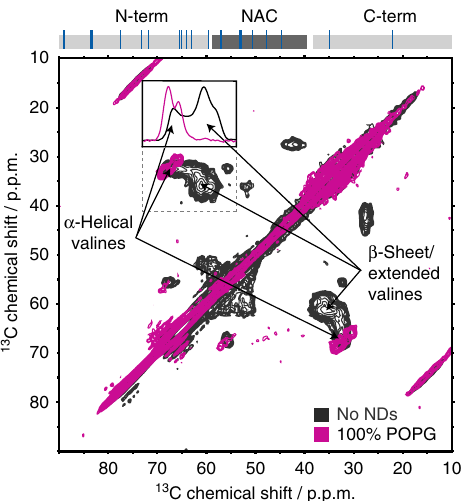
Fig. 2 Nanodiscs binding induces α -helical structure in α S. [ 13 C- 13 C]-Proton driven spin diffusion magic angle spinning-DNP spectra of free non- acetylated α S in frozen solution (black) and when bound to NDs with 100% POPG lipids (purple). Selective isotope labeling was used to speci fi cally monitor valine C α -C β chemical shift distributions. Peak positions indicative of β -sheet and α -helical secondary structure are labelled. The insert shows normalized 1D projections of the highlighted region (dashed square) in the absence (black) and presence of 100% POPG NDs. Signal deconvolution of these spectra reveals that about 92% of the valines are in an α -helical con fi guration in the presence of 100% POPG NDs. The occurrence of valine residues in the α S sequence is shown on top (blue lines). According to the respective solution NMR attenuation pro fi le (Fig. 1c, purple) 18 out of 19 valines (i.e., 94.7%) are expected in the membrane-bound state at the used conditions